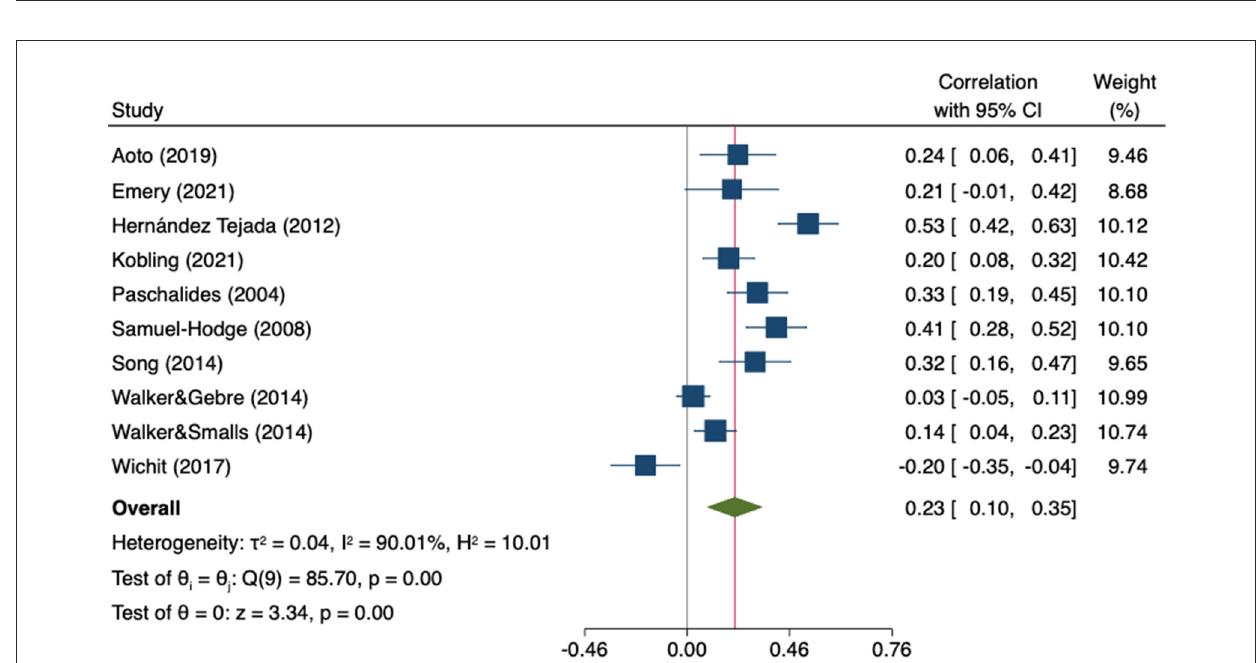
FIGURE11 Random-effects meta-analysis on the association between empowerment and mental QoL.